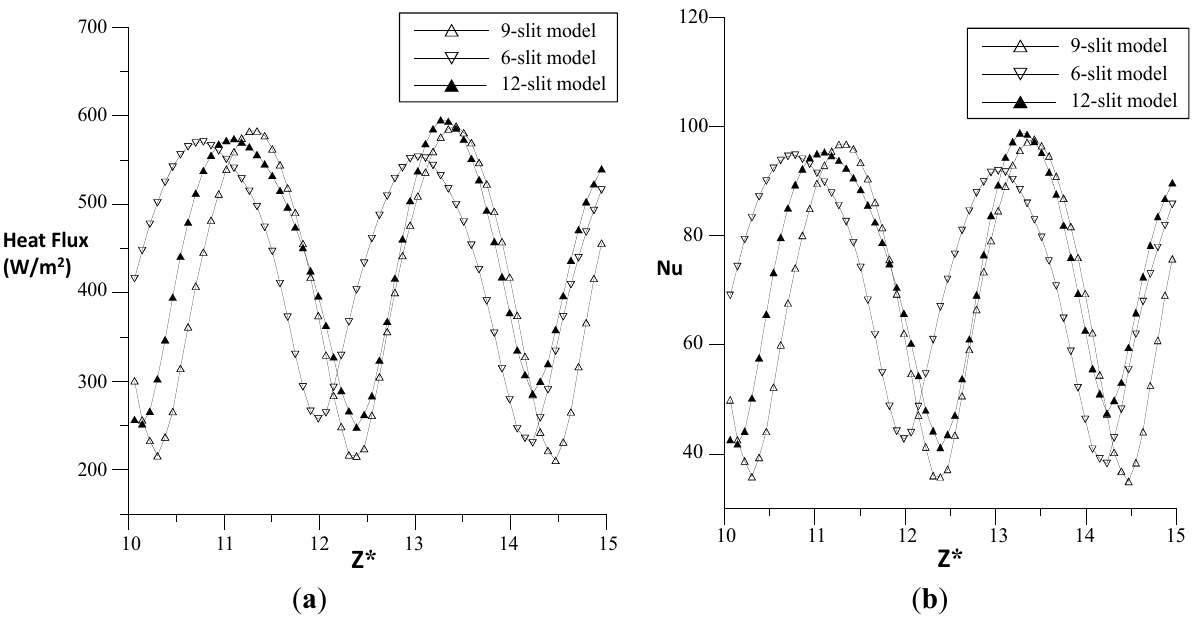
Figure 18. Axial and radial velocity profile in 6-slit model at R * = 0.8: ( a ) Axial velocity; and ( b ) Radial